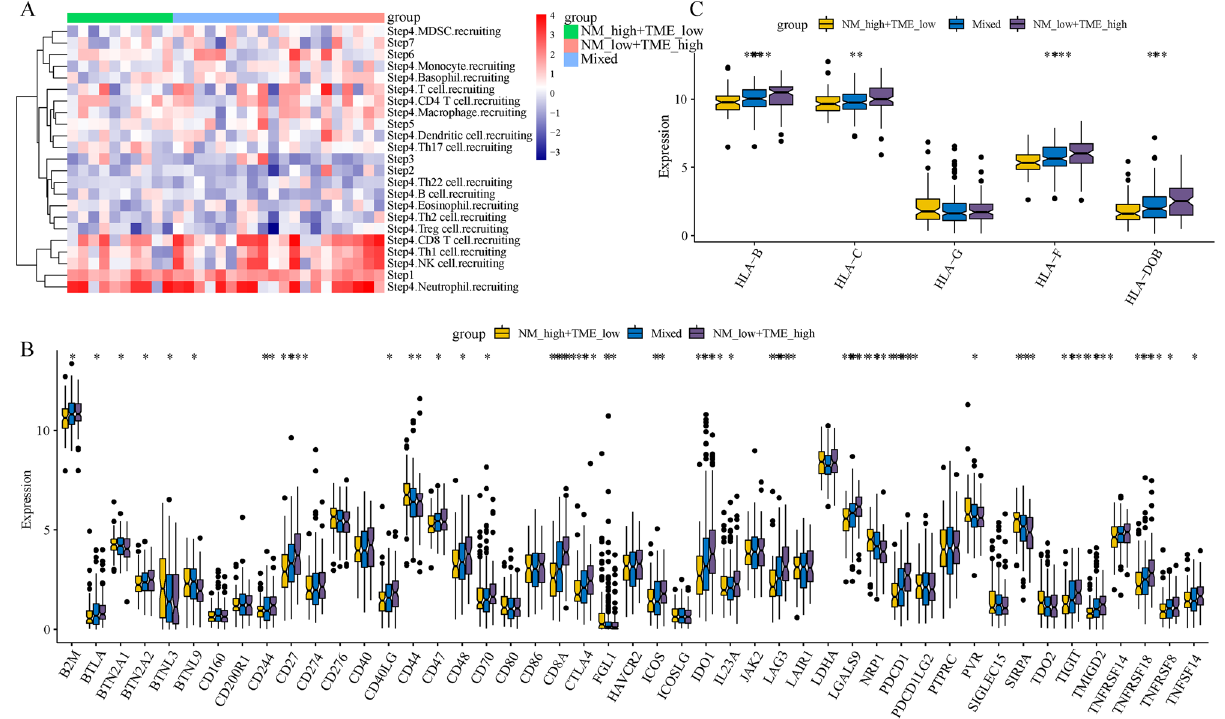
Figure 6. Immune status of different subgroups based on the NM-TME classifier. ( A ) Differences in immune cell infiltration. ( B ) Differences in ICGs. ( C ) Differences in antigen presentation-related genes in different subgroups. NM nucleotide metabolism, TME tumour microenvironment, ICG immune checkpoint